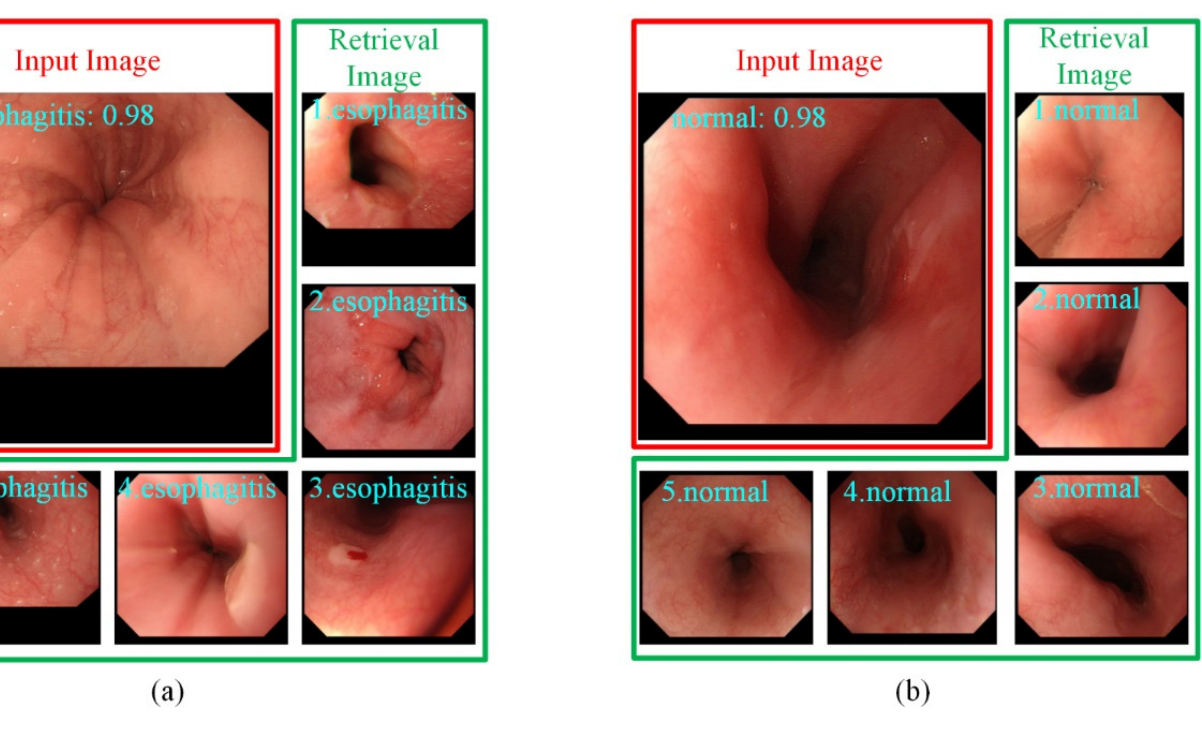
Figure 4. The top-5 most similar labeled samples are selected by images retrieval. ( a ) The input image is predicted as esophagitis. ( b ) The input image is predicted as normal.